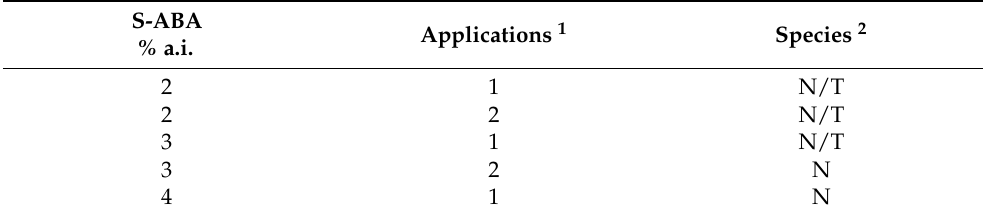
Table 3. The 2020 application summary. S-ABA concentrations, number of applications and species treated. S-ABA %